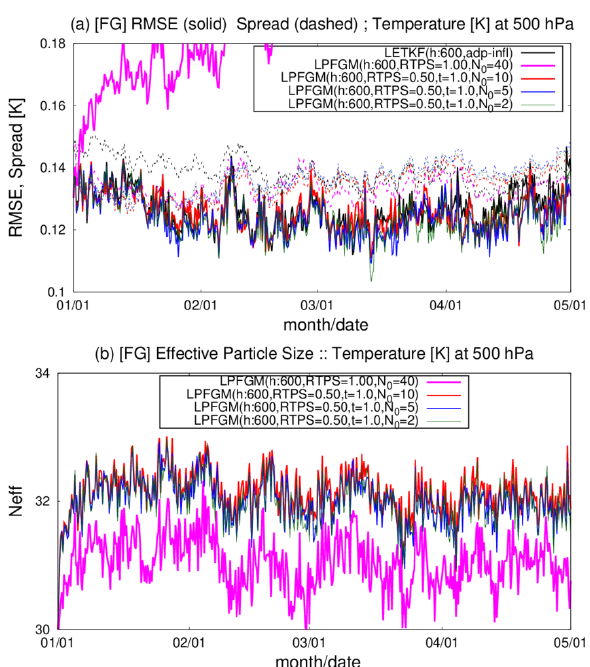
Figure 8. Similar to Fig. 6, but showing the LPFGM experiments with REG2 and 600km localization scale. Magenta, red, blue, and green lines are LPFGM experiments with N 0 = 40, 10, 5, and 2, respectively. Forgetting factor τ is 1.0. The RTPS parameter is set to 1.00 in the experiment with N 0 = 40 (i.e., all-time resampling) and to 0.50 for in other